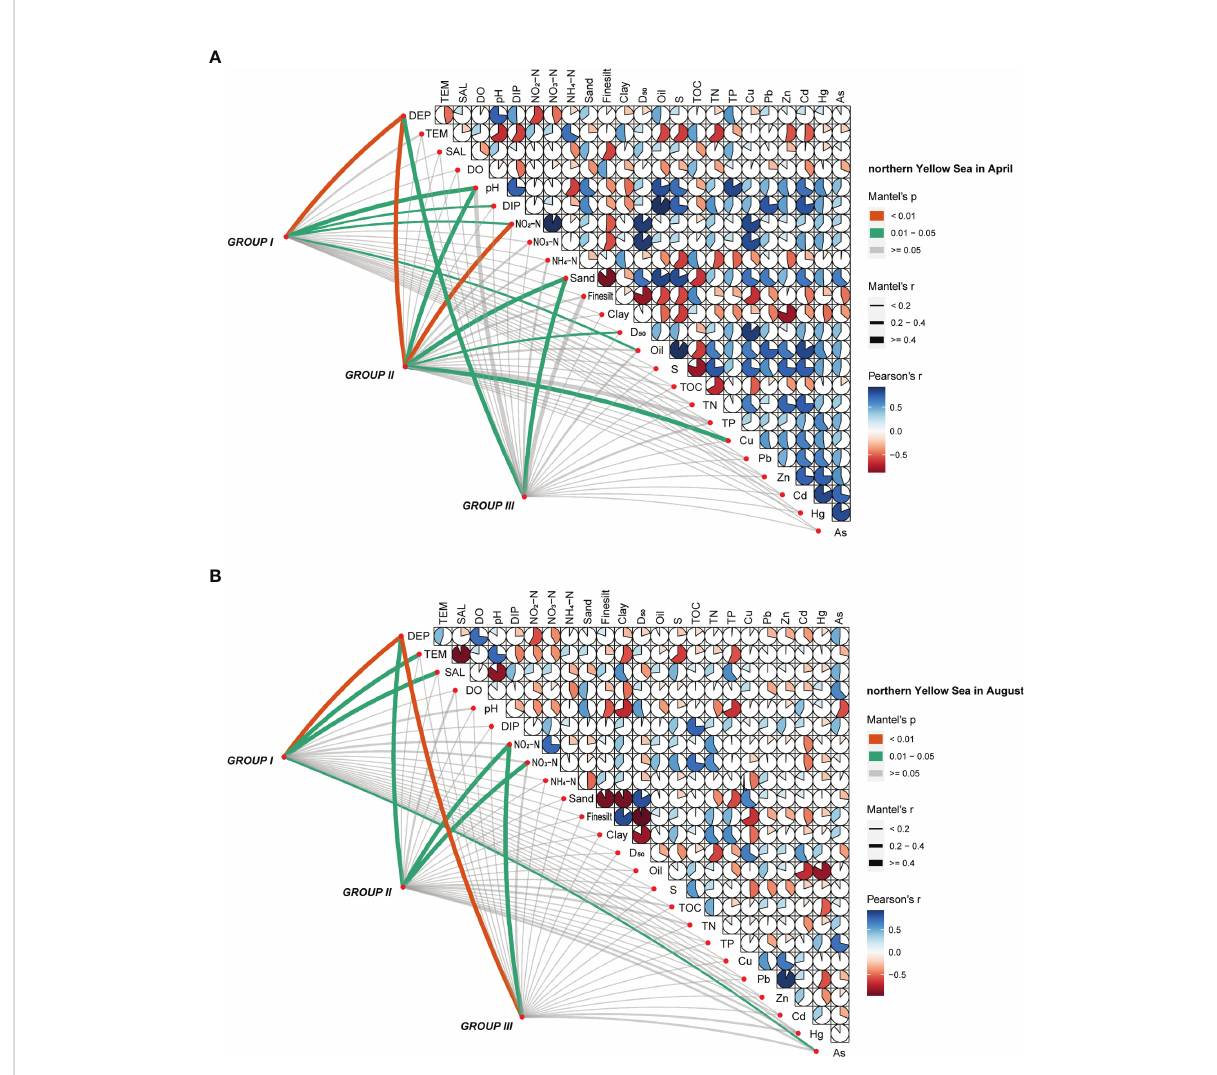
FIGURE 6 Correlations between the major macrobenthic communities and environmental factors by month, in (A) April and (B) August of 2020, in the northern Yellow Sea